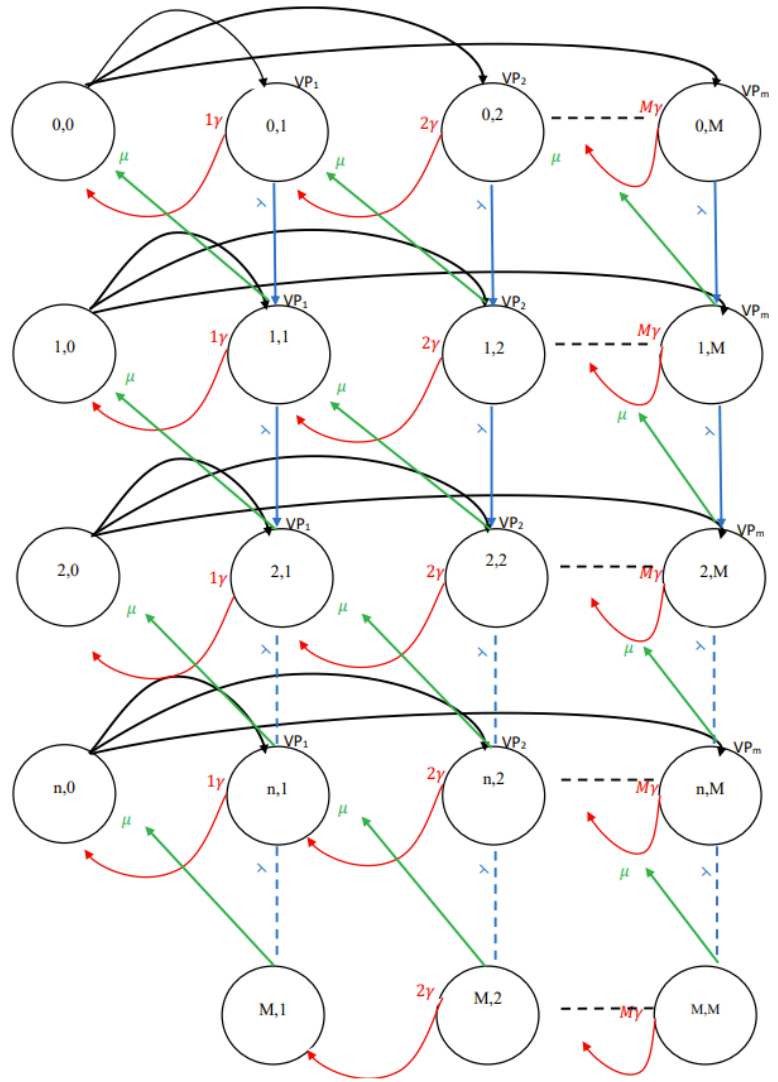
Figure 2. M / M /1/ N − 1-systems with inventory, lost sales and